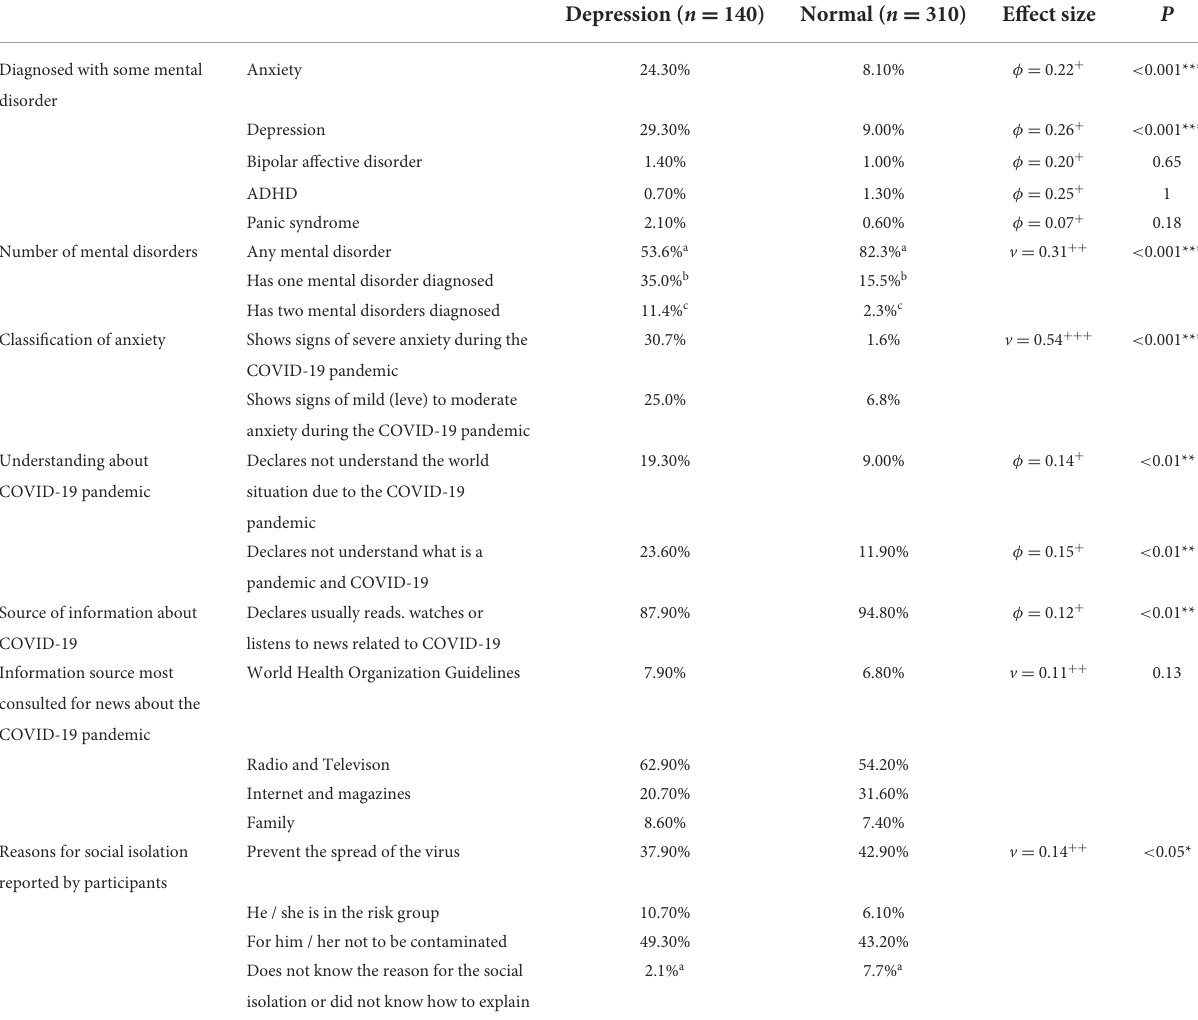
TABLE 1 Psychological responses and participants’ perceptions about the COVID-19